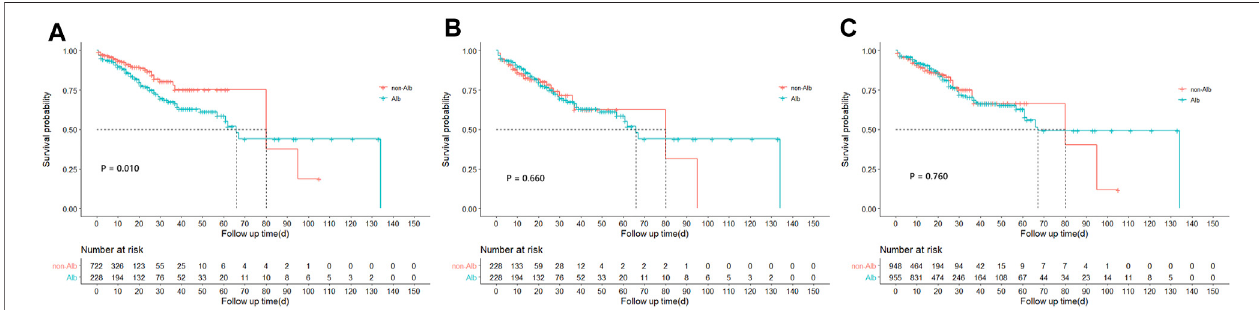
FIGURE 2| Kaplan-Meiresurvival curve analysis between treatment groups before and after matching from the MIMIC-IV database. (A) Survival curves ofhospital mortality in acute pancreatitis patients between treatment groups before matching from the MIMIC-IV database. (B) Survival curves of hospital mortality in acute pancreatitis patients between treatment groups after PSM matching from the MIMIC-IV database. (C) Survival curves of hospital mortality in acute pancreatitis patients between treatment groups after IPTW matching from the MIMIC-IV database. PSM, propensity score matching; IPTW, inverse probability of treatment weighing.